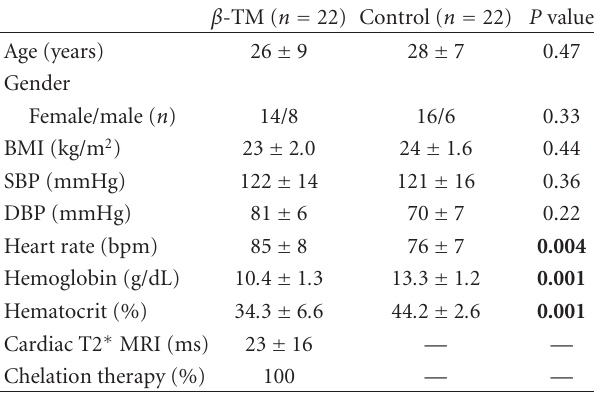
Table 1: Clinical, demographic, and laboratory characteristics of the study population.